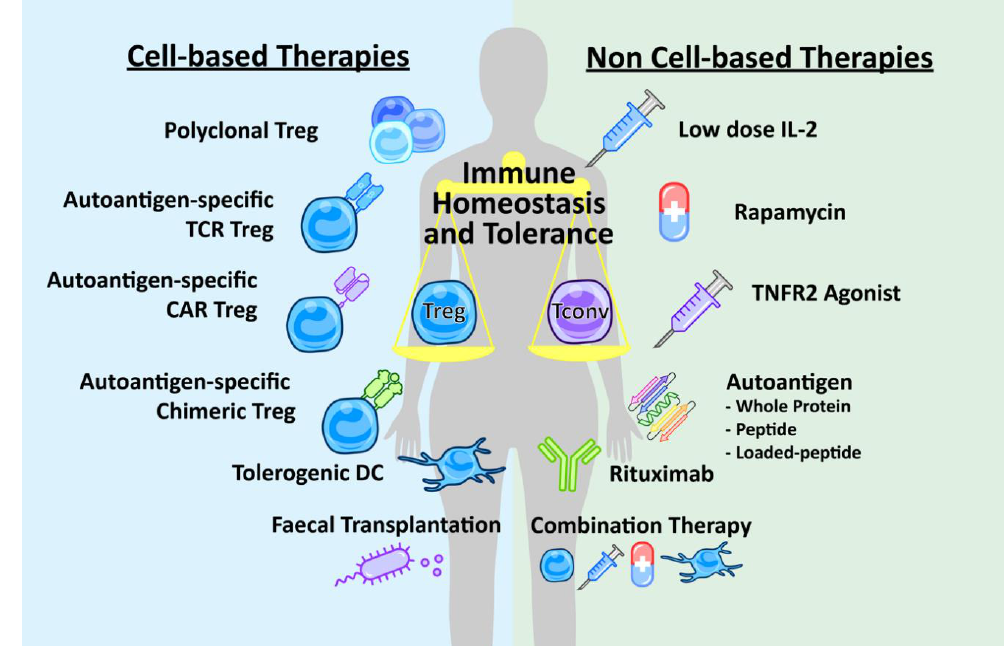
Figure 1. New therapeutic approaches for autoimmune disease. A variety of cell-based therapies and non-cell-based therapies are currently being explored in the treatment and prevention of autoimmune diseases. There are cell-based therapies, such as ex vivo-expanded polyclonal Tregs or Tregs transduced with an autoantigen-specific T cell receptor (TCR), chimeric antigen receptor (CAR), or other